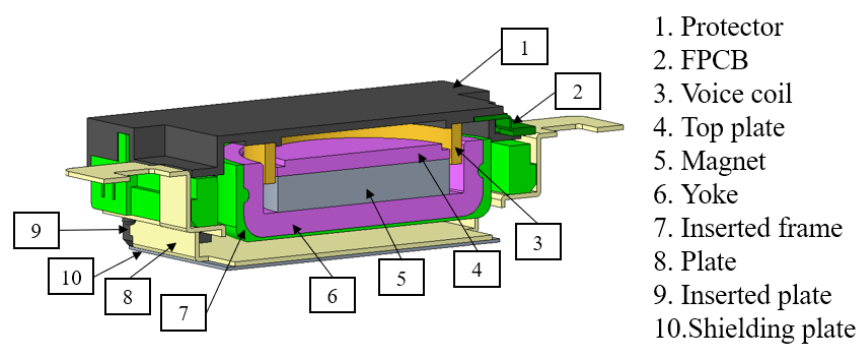
Figure 12. Magnetic shielding: ( a ) without shielding; ( b ) with shielding.